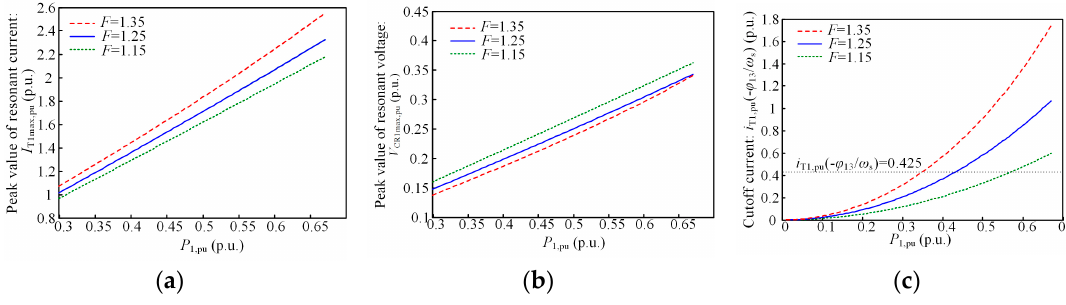
Figure 10. Circuit operating characteristics versus P 1,pu under varying F : ( a ) I T1max,pu ; ( b ): V CR1max,pu ; ( c ): i T1,pu (– ϕ 13 / ω s ).